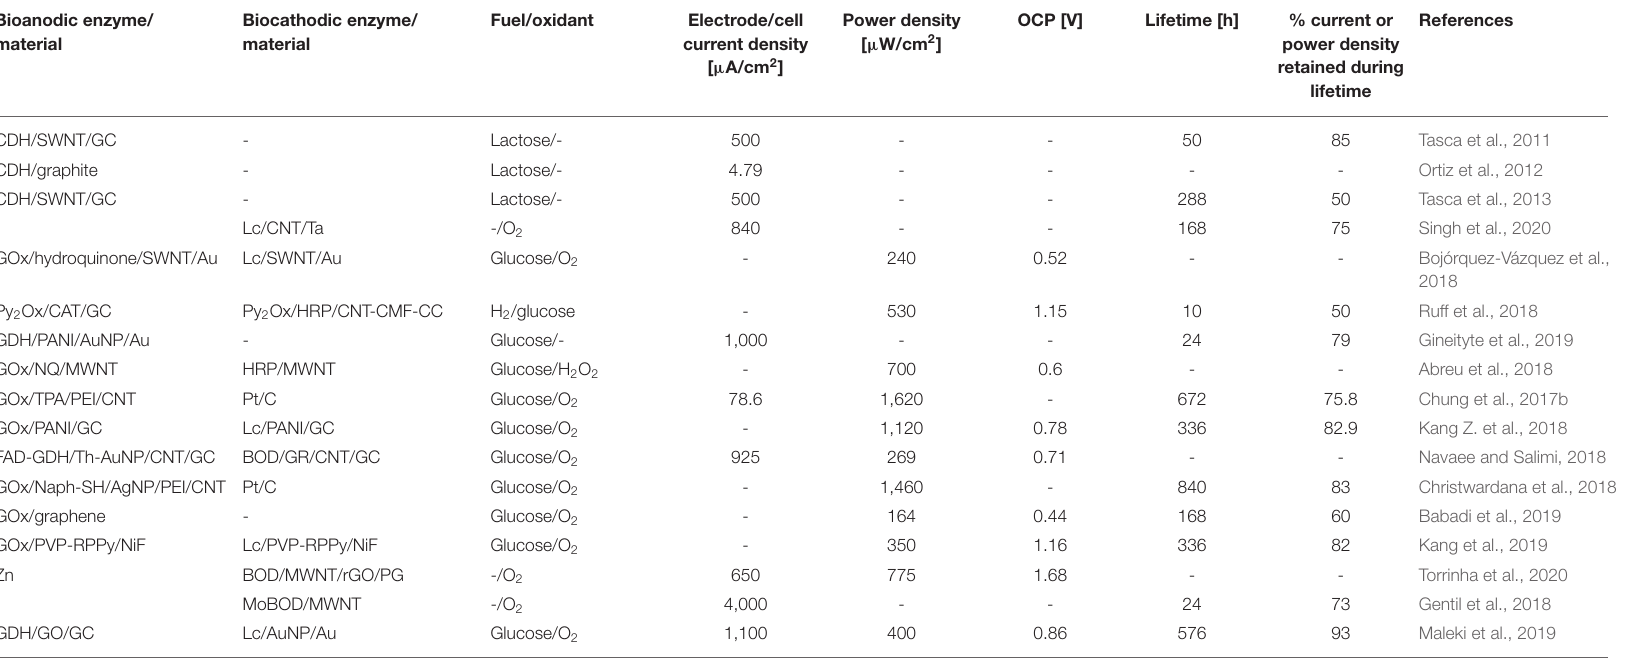
TABLE 1 | Performances of electrodes and enzymatic fuel cells operating on direct electron transfer. Bioanodic enzyme/ Biocathodic enzyme/ material